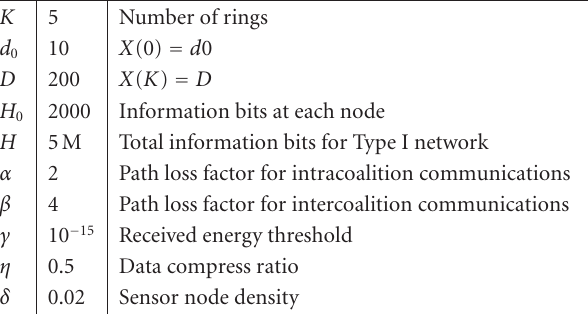
Table 2: Numerical